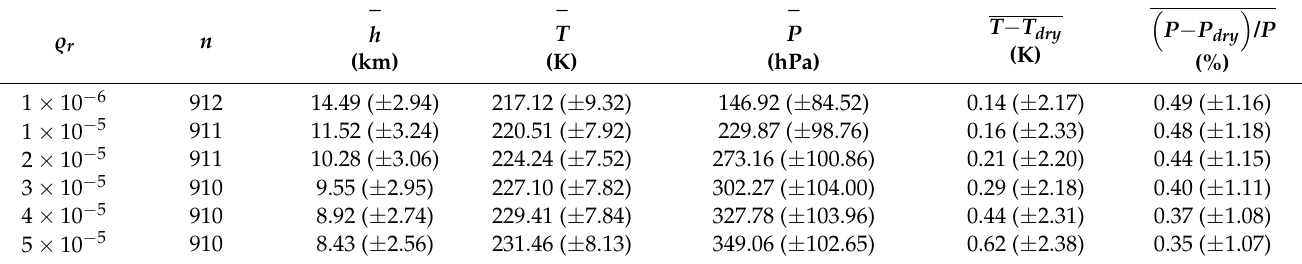
Table 1. Mean values of altitude, temperature, temperature − dry temperature and relative pressure − dry pressure differences together with the number of samples corresponding to given values of mixing ratio. Uncertainties are also given in brackets. (cid:36)